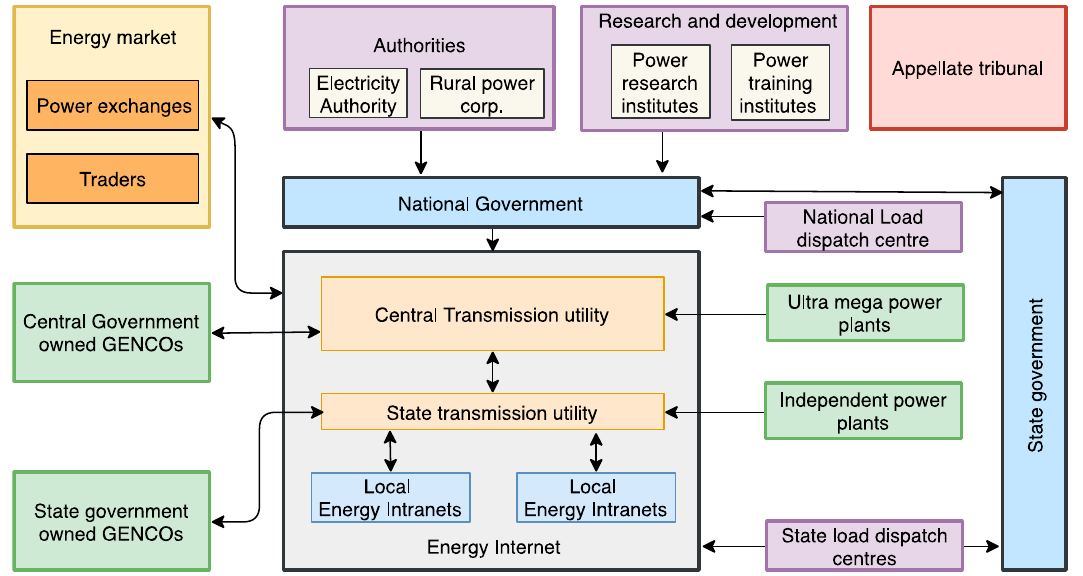
Figure 8. Proposed industry structure with Energy Internet.